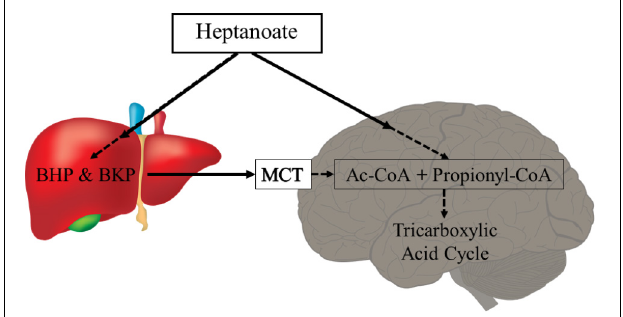
FIGURE 3 | Heptanoate metabolism. Heptanoate can be taken up by the liver to produce the C5 ketone bodies, β -hydroxypentanoate (BHP) and β -ketopentanoate (BKP), which are then released into blood and taken up by cells through monocarboxylate transporters (MCT). It is also likely that heptanoate directly diffuses into cells, including brain cells. In mitochondria, heptanoate metabolites produce acetyl-CoA and anaplerotic propionyl-CoA, which can enter the TCA cycle directly or after carboxylation as succinyl-CoA,